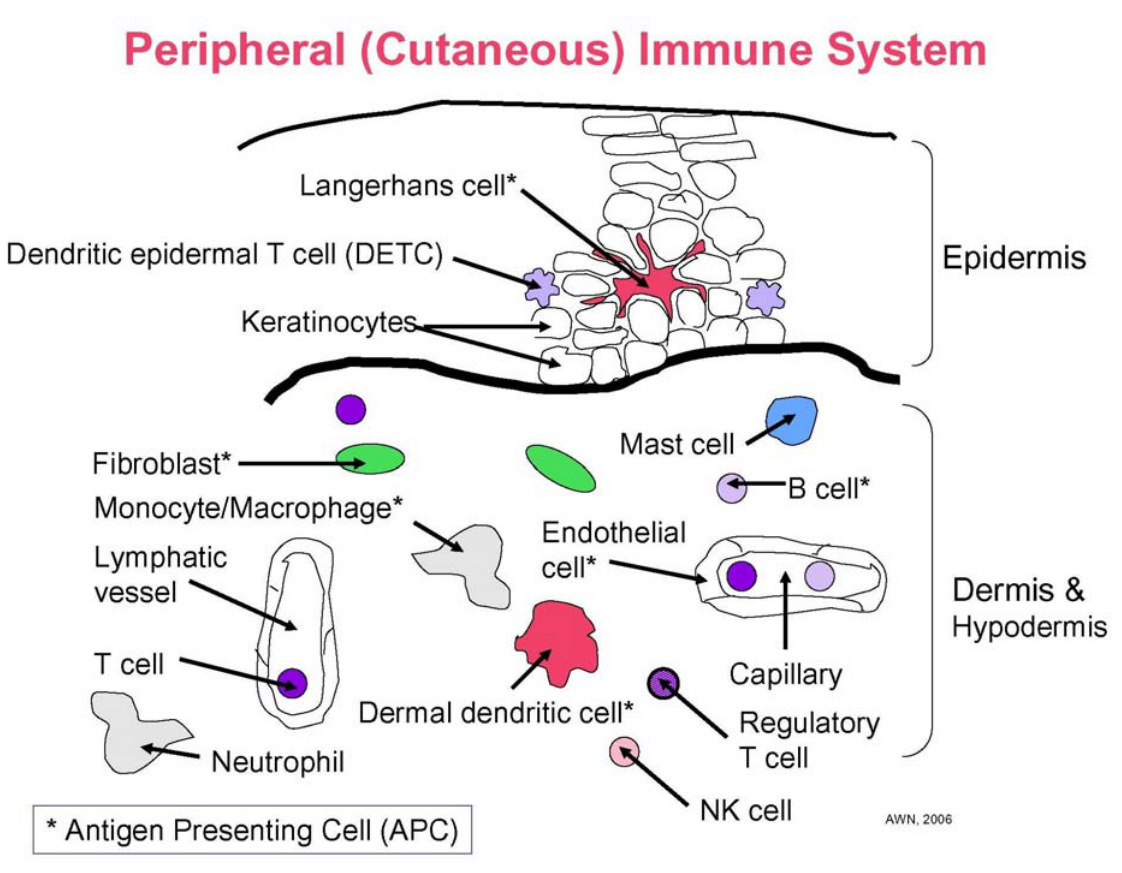
FIGURE 1. Cells of the peripheral immune system in amphibian skin. Although not well studied in urodeles, postmetamorphic anurans appear to have most components of cutaneous immunity found in mammalian skin. (Modified from [60].)